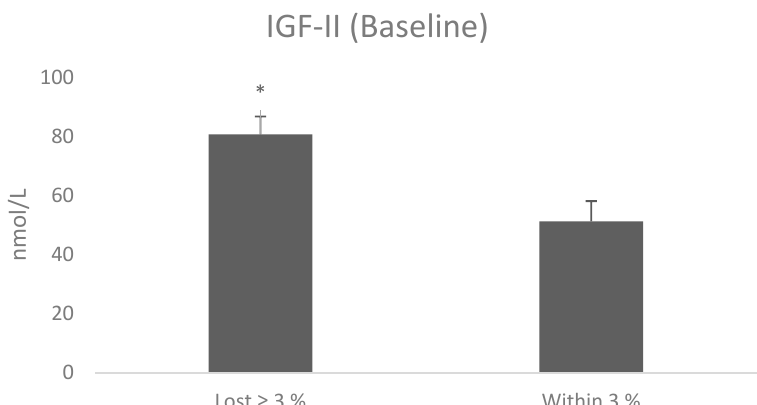
Figure 3. Insulin-like growth factor II (IGF-II) baseline levels between patients who lost ≥ 3% in body weight and those patients who remained within 3% of their starting weight. The values were analysed by T test and are shown as mean ± SE. * p < 0.05.